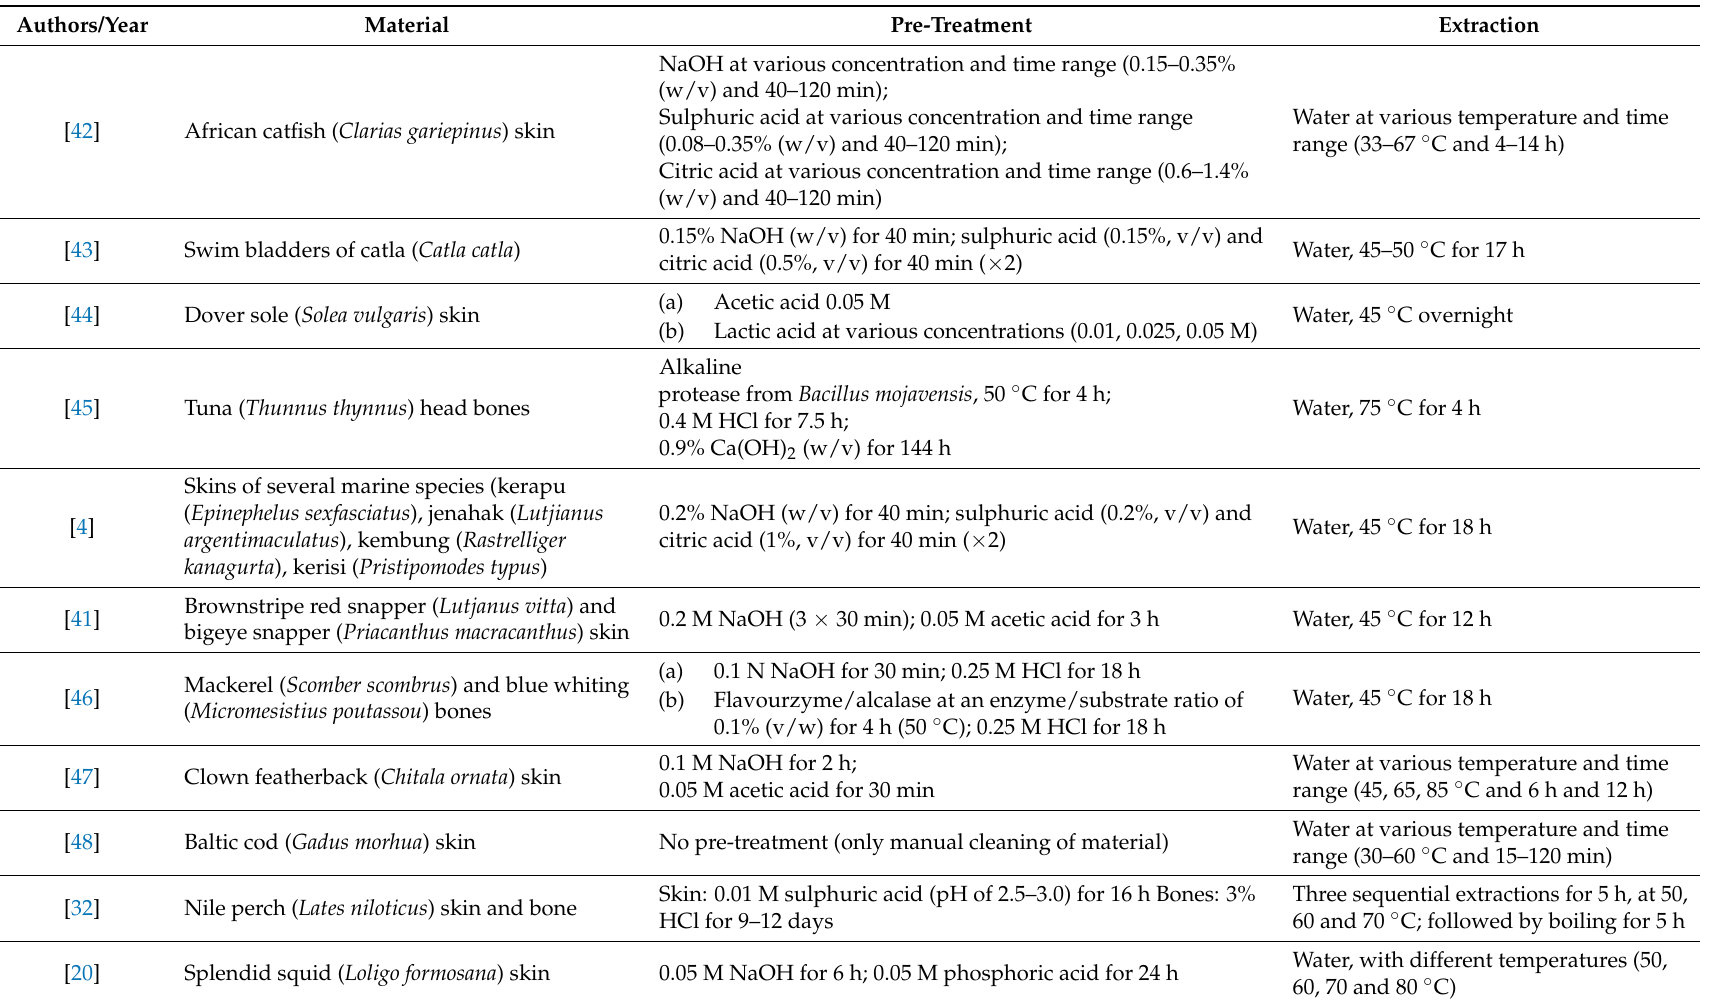
Table 2. Examples of gelatine pre-treatment and extraction